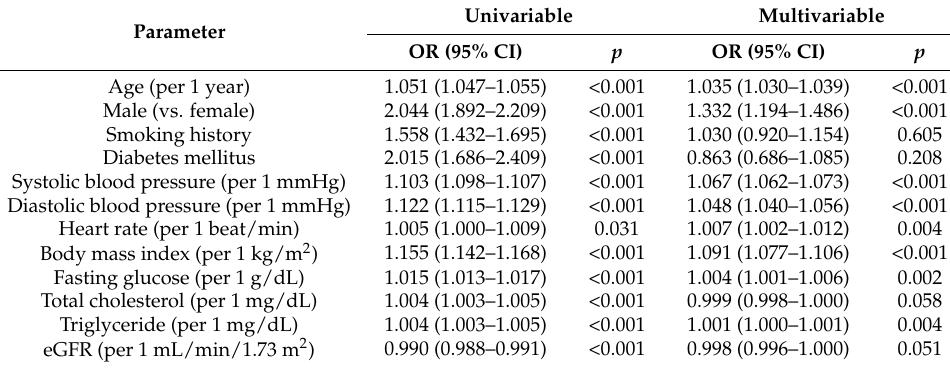
Table 3. Determinants of new-onset hypertension using binary logistic analysis in the new definition population (hypertension was defined as systolic blood pressure ≥ 130 mmHg or diastolic blood pressure ≥ 80